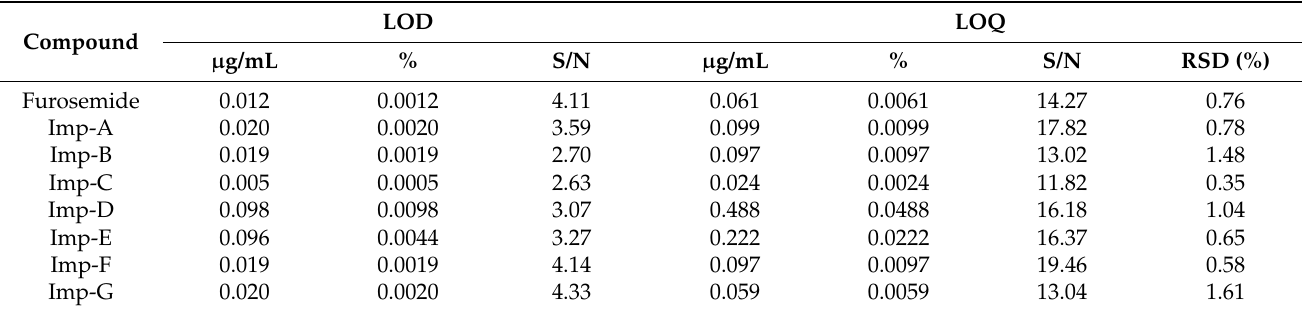
Table 3. LODs and LOQs data of furosemide and impurity A–G.